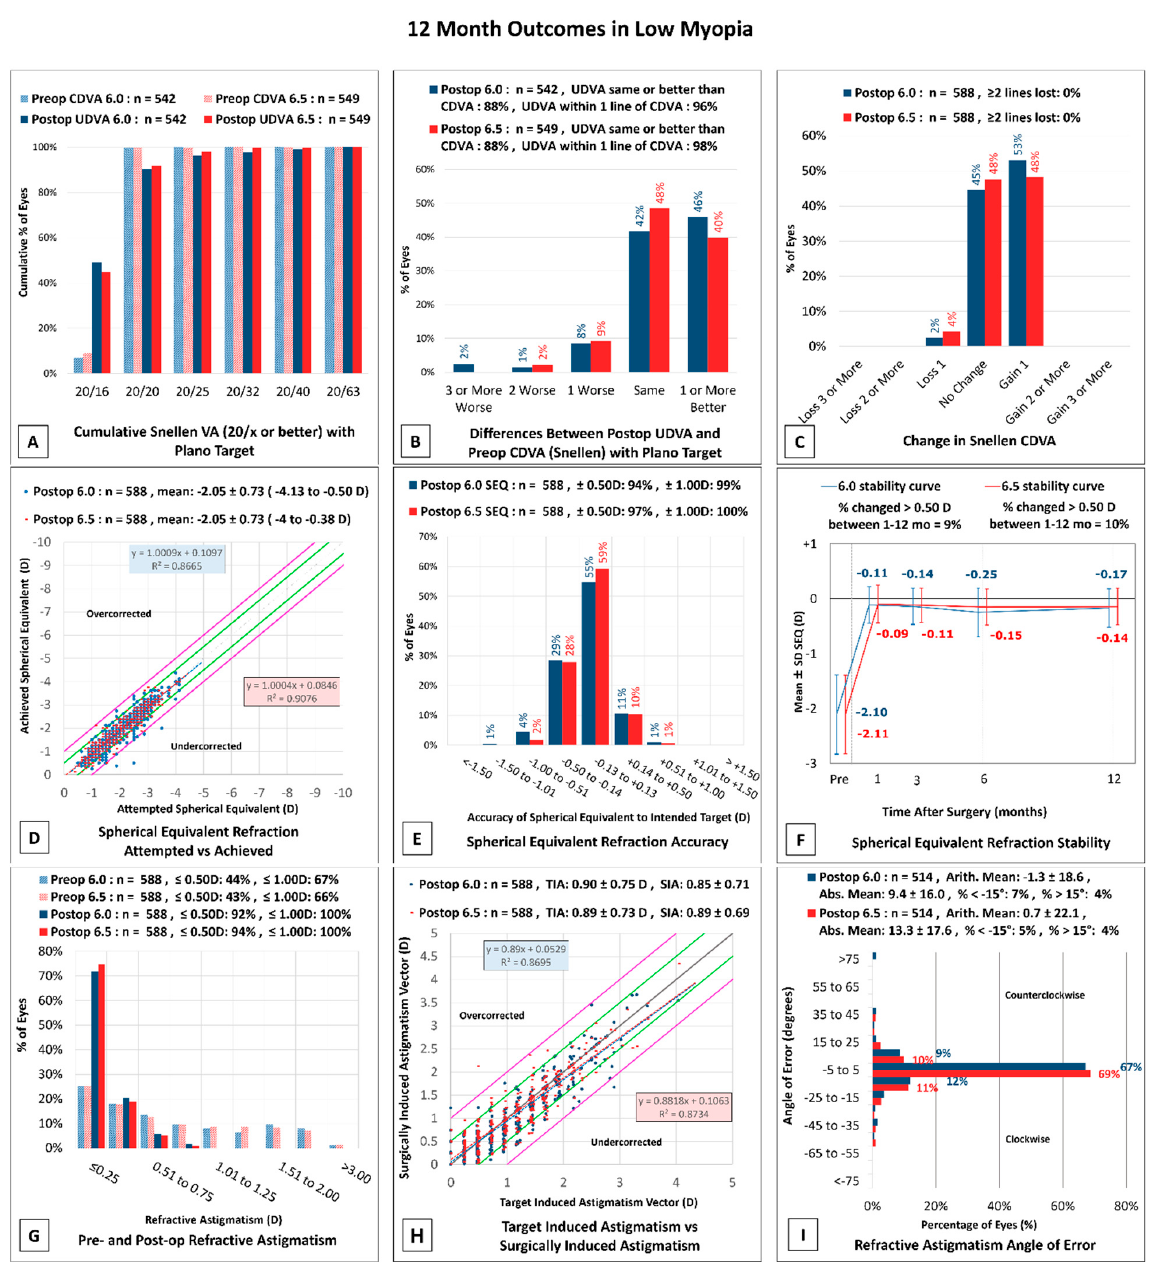
Figure A1. Standard reporting of visual and refractive outcomes for eyes at twelve months postoperatively between 6.0 and 6.5 mm in Low Myopia. ( A ) Cumulative preoperative CDVA and postoperative UDVA; ( B ) difference between preoperative CDVA and postoperative UDVA; ( C ) change in Snellen CDVA; ( D ) attempted vs. achieved MRSE; ( E ) accuracy of MRSE; ( F ) MRSE stability at one, three, six, and 12 months; ( G ) comparison of preoperative and postoperative manifest cylinder; ( H ) target-induced vs. surgically-induced astigmatism; ( I ) angle of error.